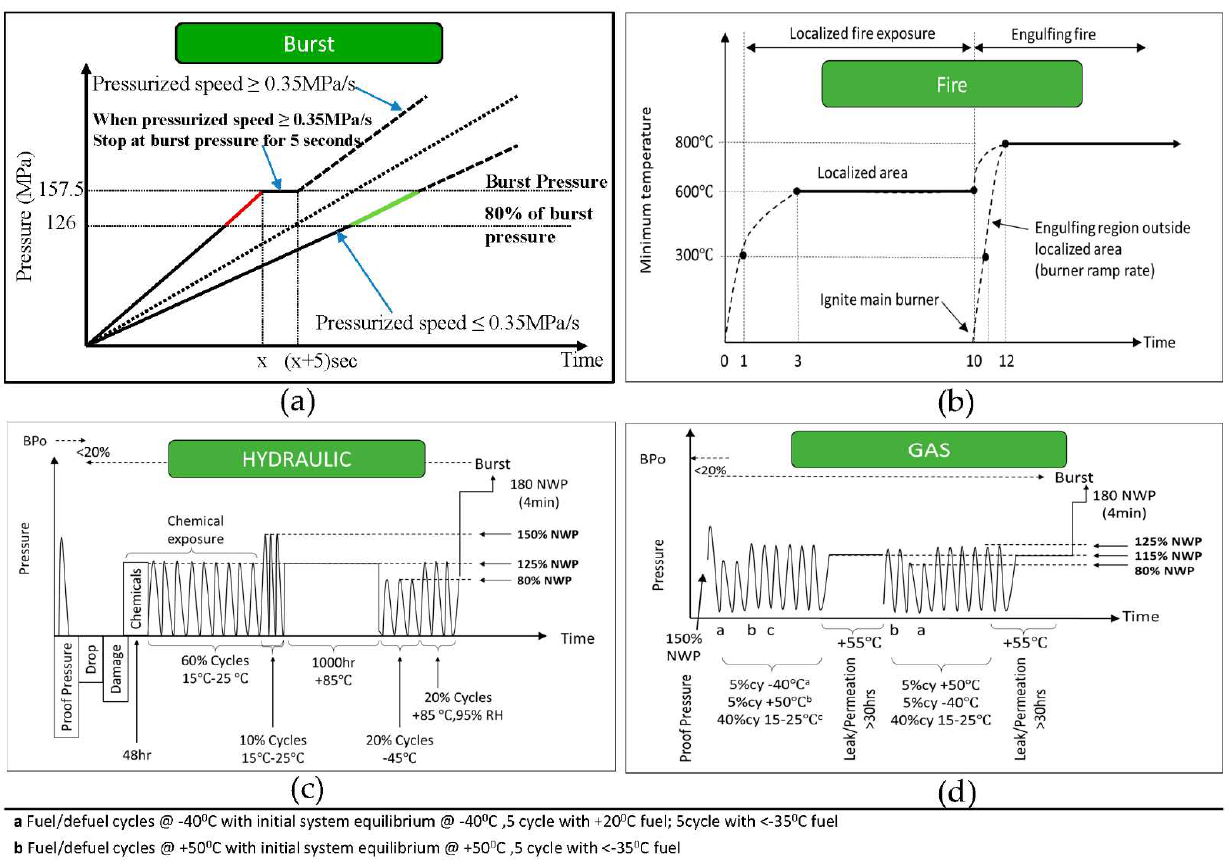
Figure 12. Certification testing overview—UN GTR 13 [178]: ( a ) hydrostatic burst test; ( b ) flame exposure test; ( c ) durability test (hydraulic); ( d ) durability test (gas).